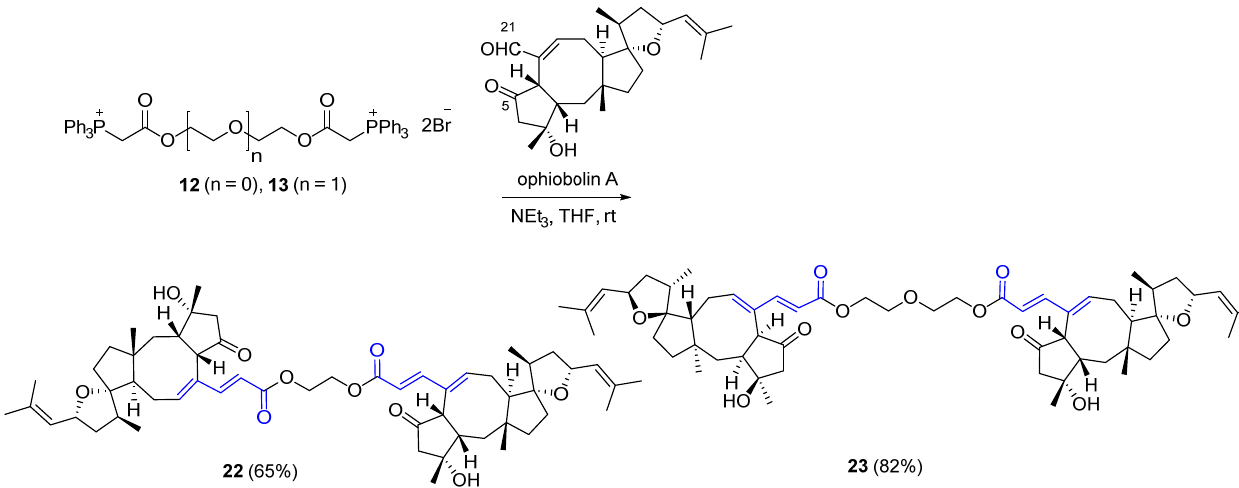
Figure 6. Synthesis of ophiobolin A-based crosslinking agents 22 and 23.